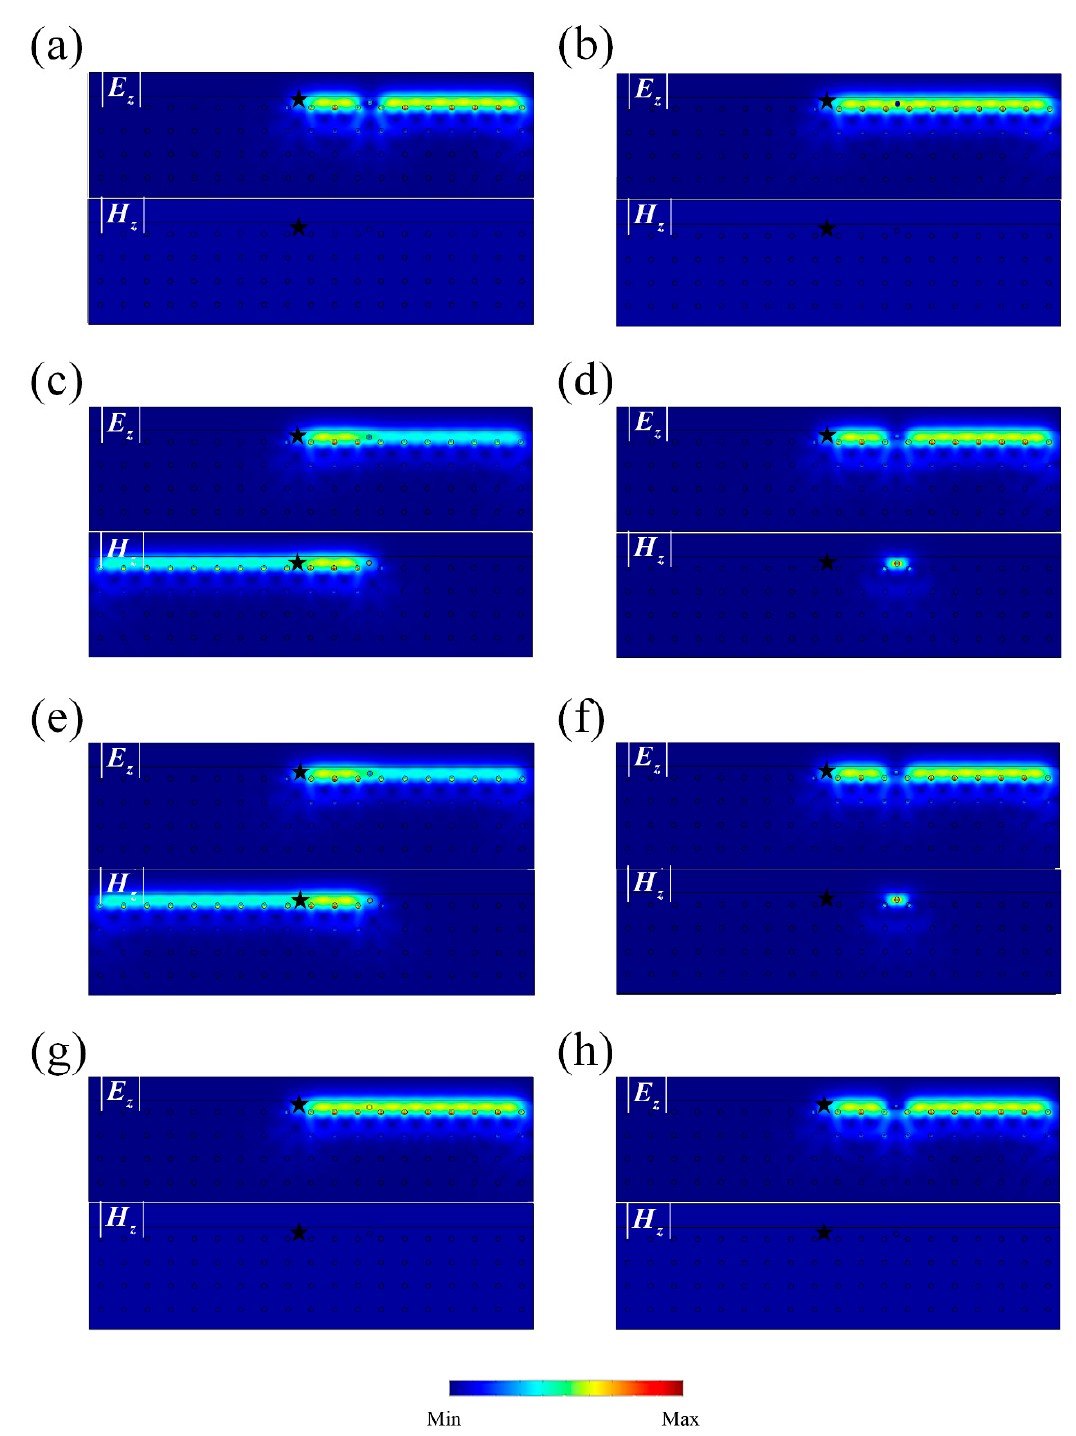
Figure 3. Field distribution with impurities. ( a – h ) Field distribution with impurities shown in Table 1. The black star presents an E z incidence point source while the impurity is set as a circle. Each upper picture shows | E z | distribution and the lower one shows | H z | distribution. The color on site represents the amplitude of | E z | or | H z | . All of the backscattering phenomenon match the commutation results in Table 1, except for ( b ) ˆ H iI and ( g ) ˆ H z .